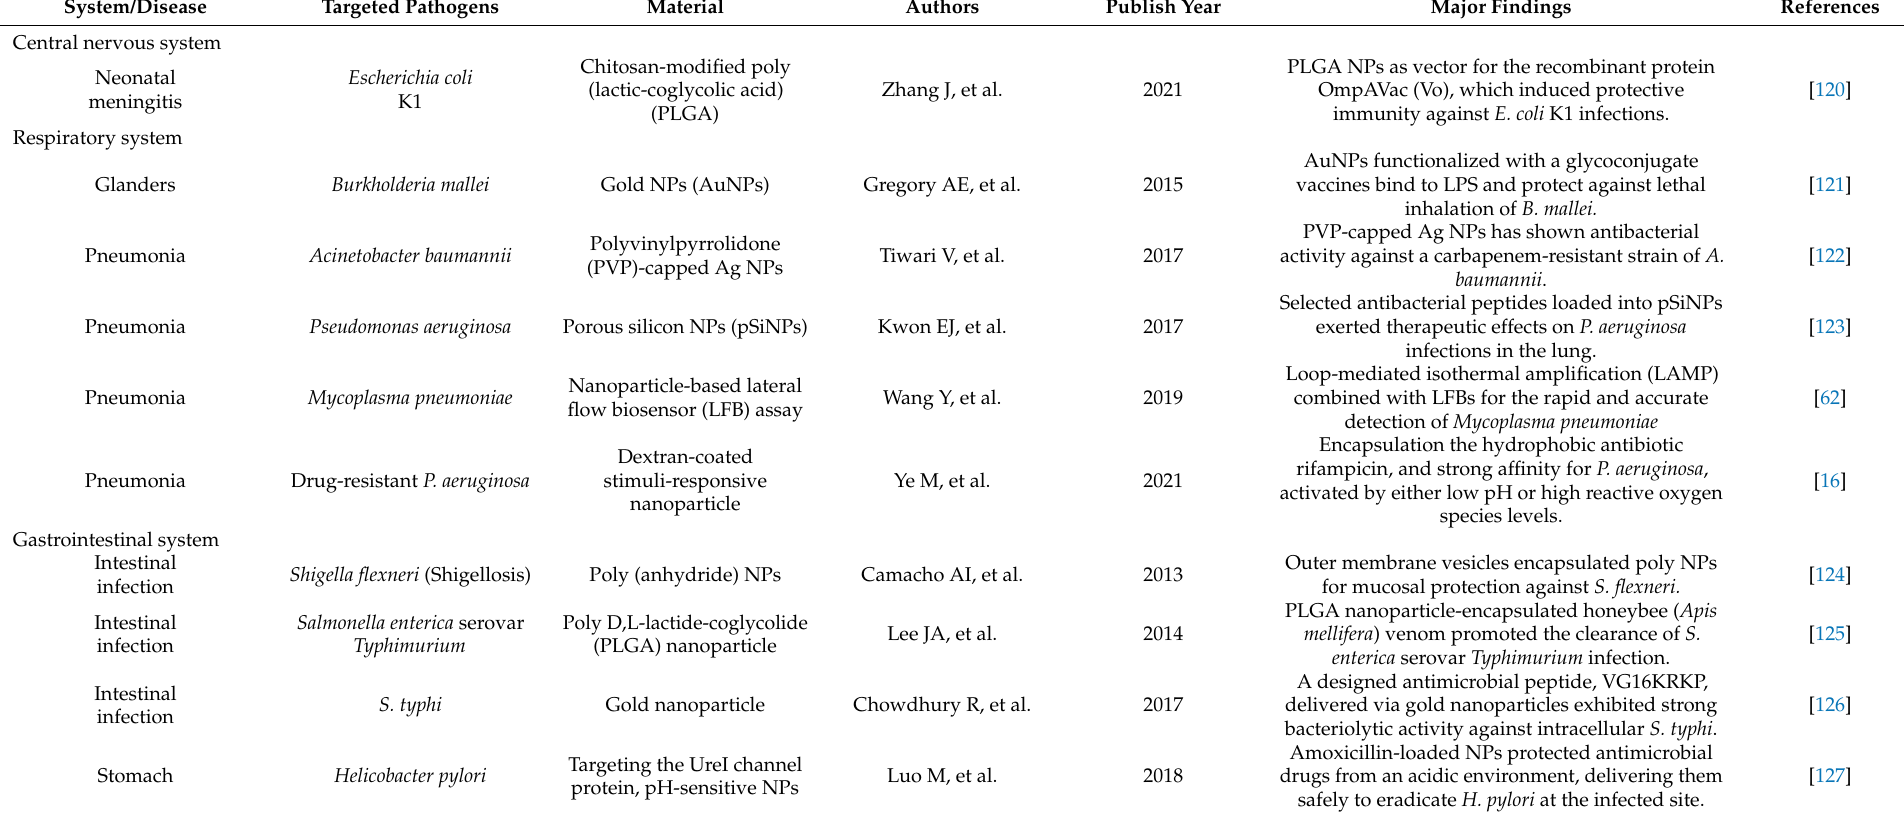
Table 1. Advances in the development of NPs to treat bacterial infectious